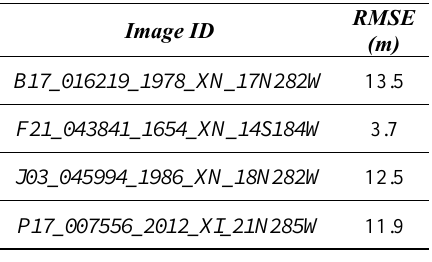
Table 2. Quantitative comparison between the DEMs generated by our CNN approach and the reference